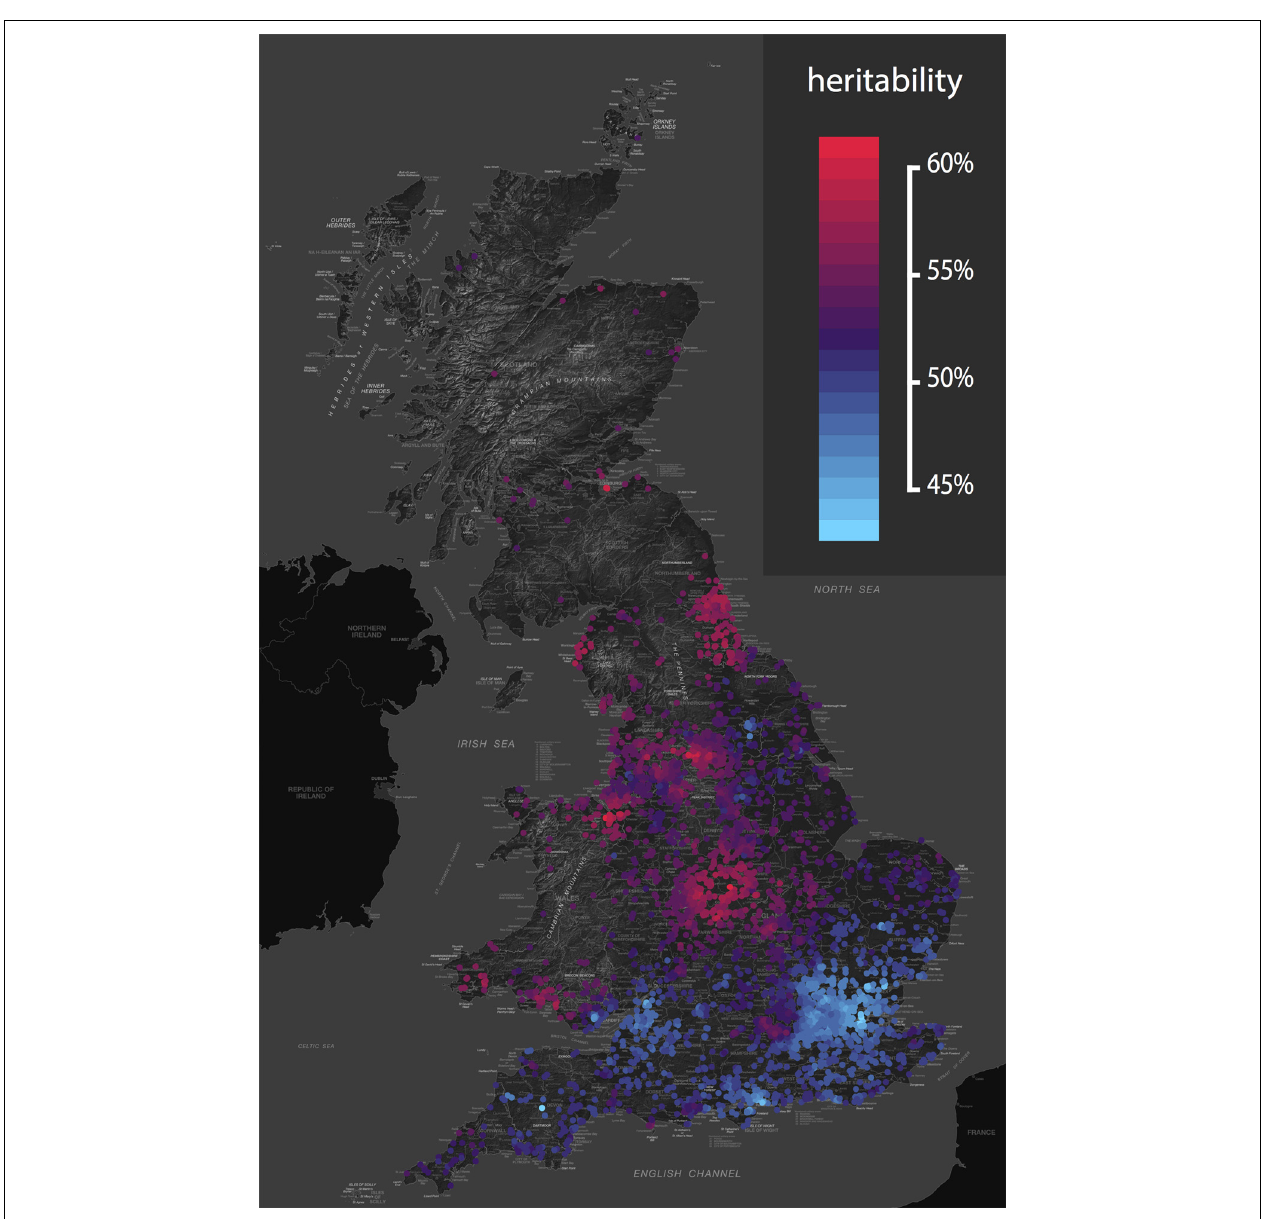
genetic differences between people. For example, genetic influences on hay fever would not be noticeable in a region without wind-pollinated crops, yet in an area with airborne pollen, genetic propensities to hay fever will be revealed. Again, analysis of raw variance components tells us that these geographical differences in genetic influence cannot be explained by simple reciprocal differences in the variability of the local environment. Genetic and environmental maps of the UK for 45 childhood phenotypes are available from